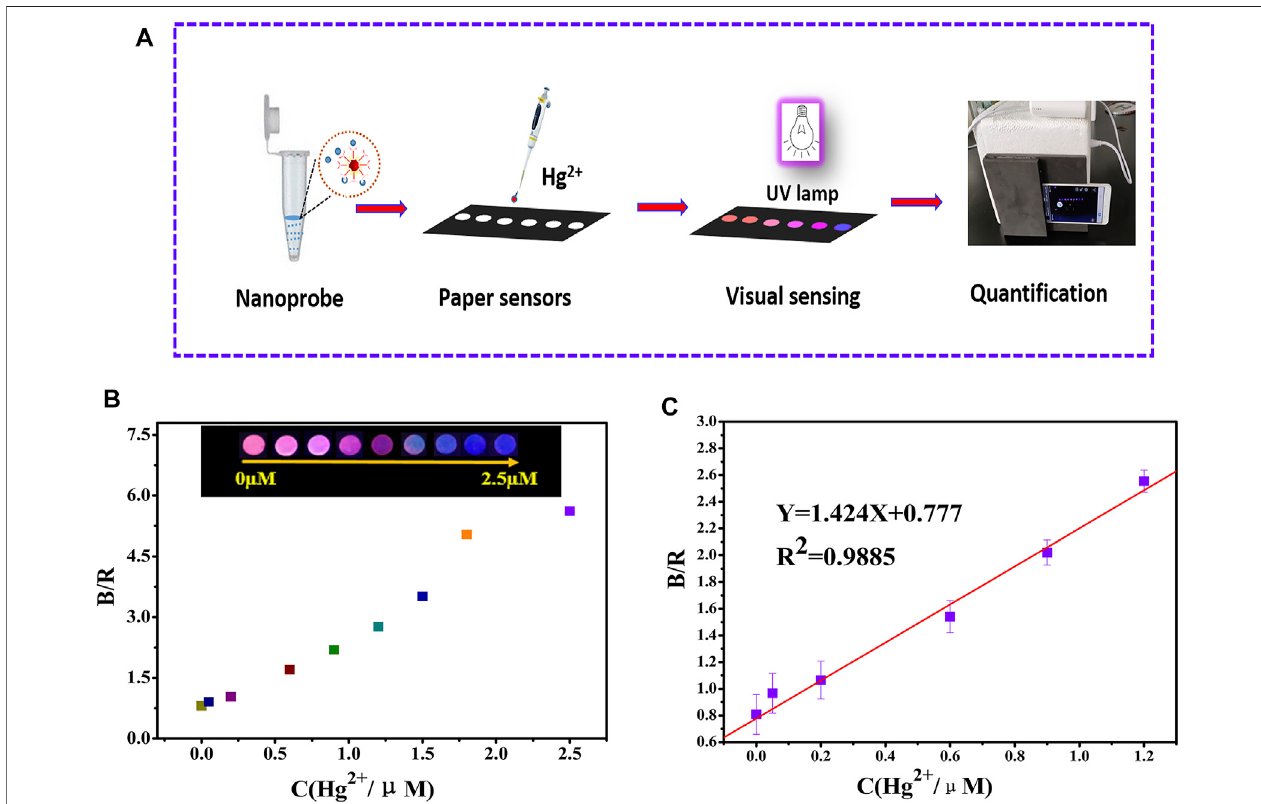
FIGURE 4 | (A) The schematic diagram of visual and quantitative detection of mercury ions by the paper-based sensor platform; (B) smart phone recognition paper-based sensor detection of mercury ions and data (C) .